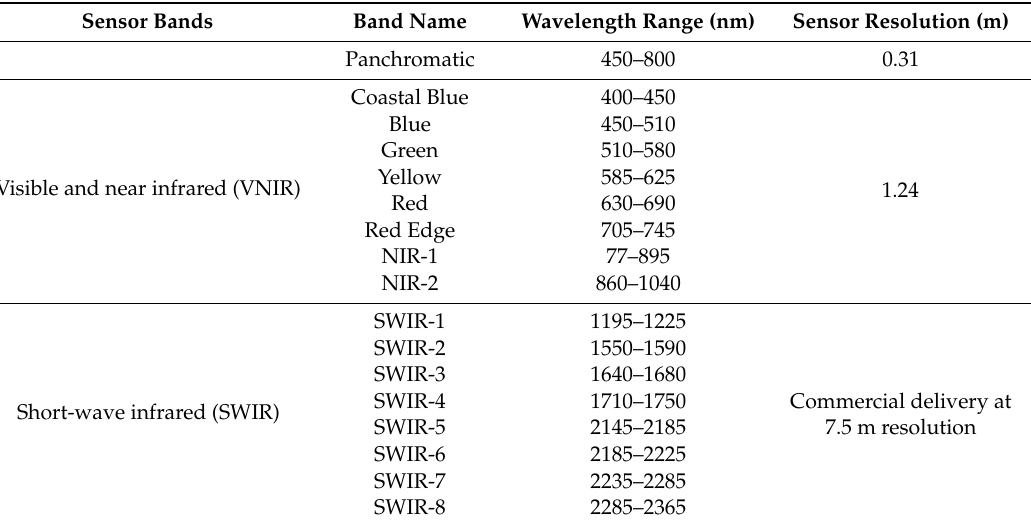
Table 1. Main specification of worldview-3 [34].